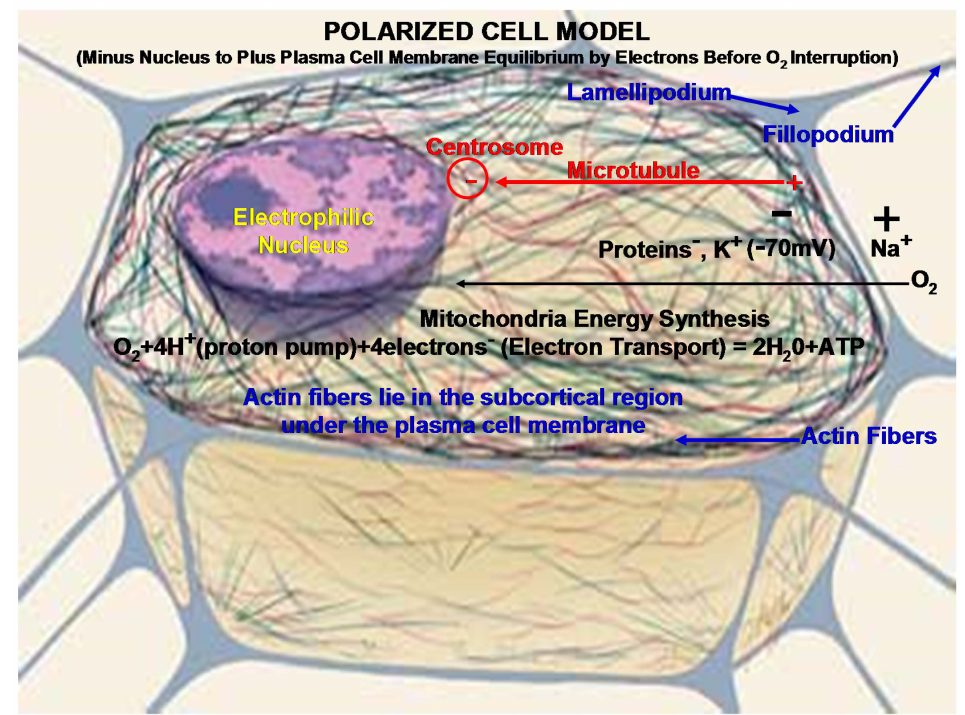
Figure 6. Polarized mitochondrial energy synthesis cell model with cytoskeleton fibers and lamellipodium projections and fillopodium focal adhesions. With permission from National Institutes of Health/Department of Health and Human Services. All subsequent text labels and arrows created by